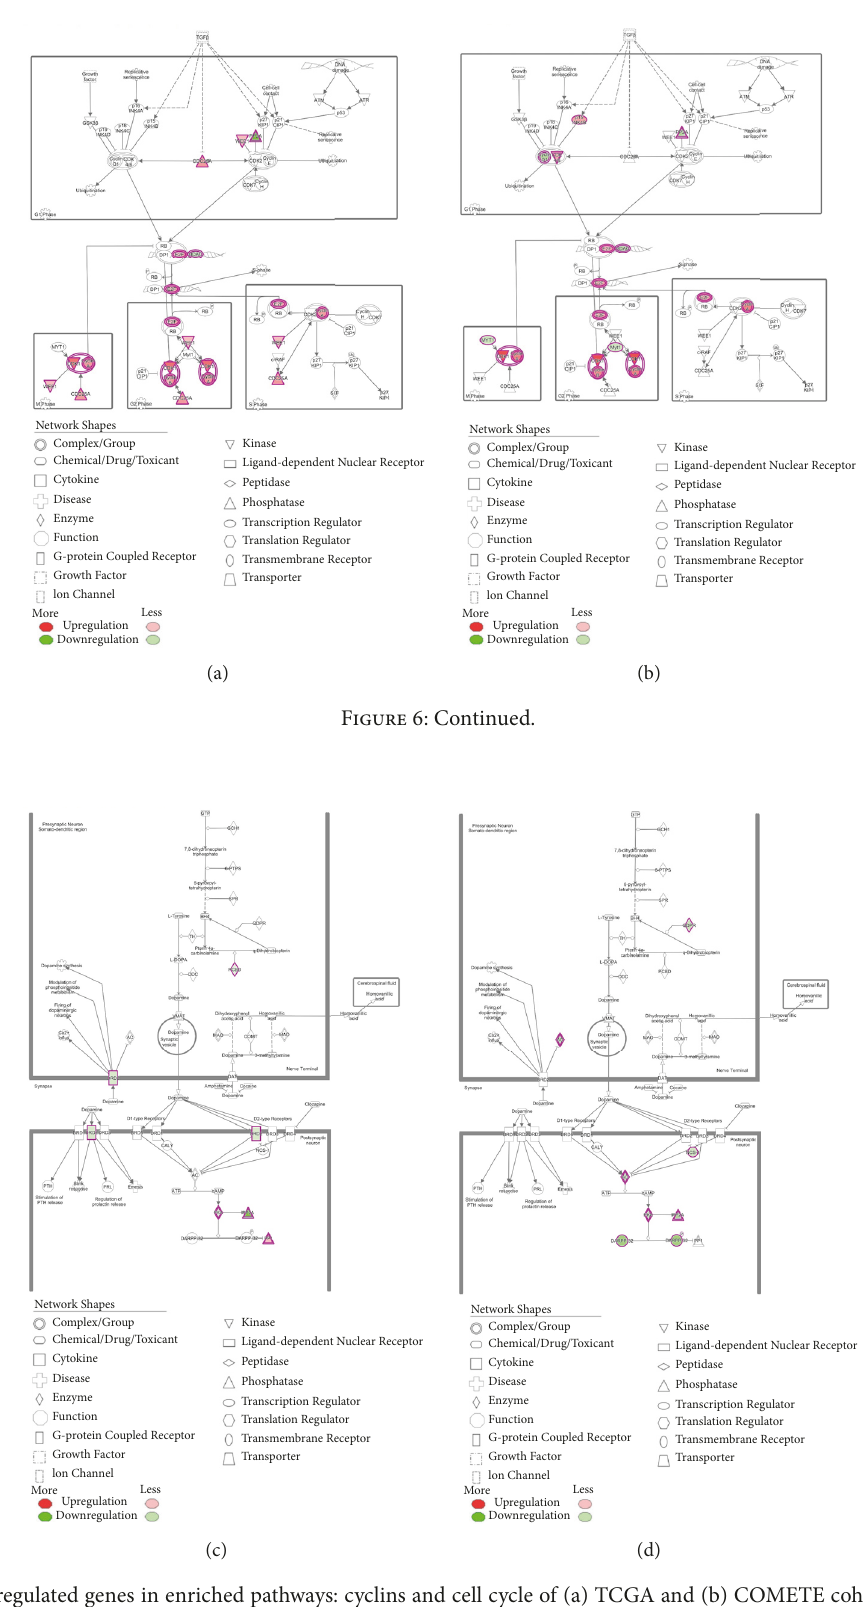
Figure 6: Up/downregulated genes in enriched pathways: cyclins and cell cycle of (a) TCGA and (b) COMETE cohort and dopaminergic synapse of (c) TCGA and (d) COMETE